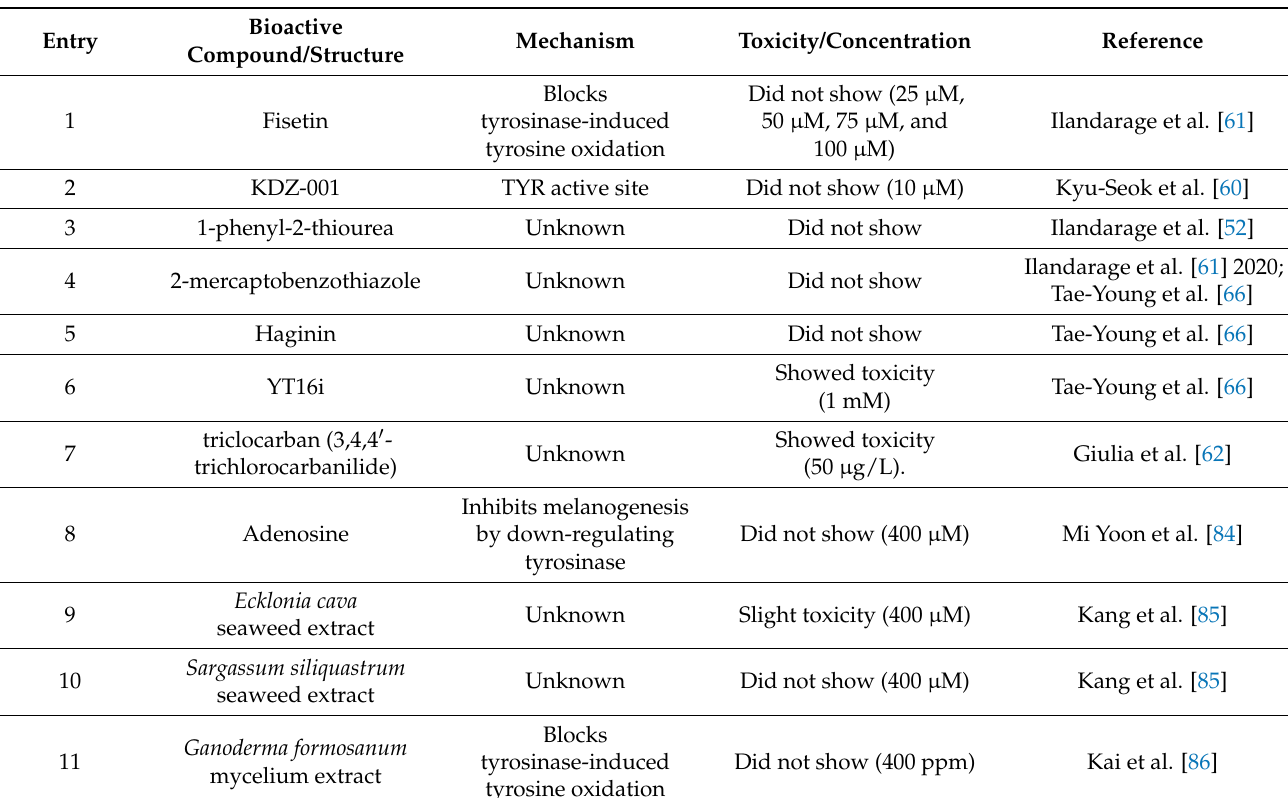
Table 2. Compounds and metabolites derived from plant species used as melanogenesis inhibitors in zebrafish embryos relative to concentration and